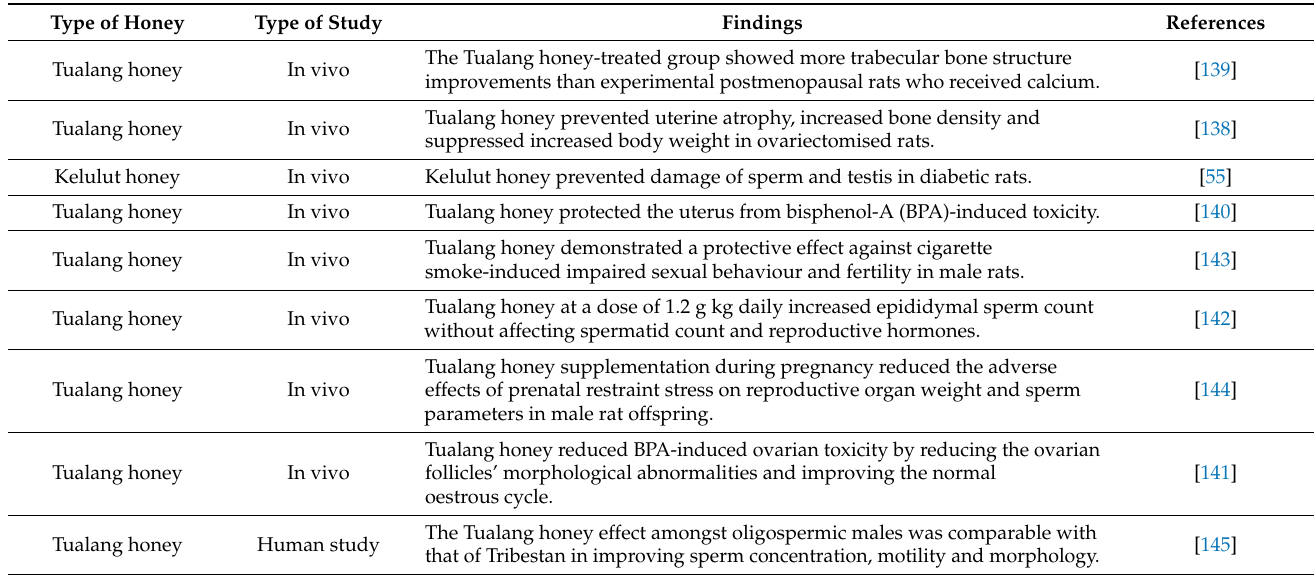
Table 11. Summary of the effects on reproductive